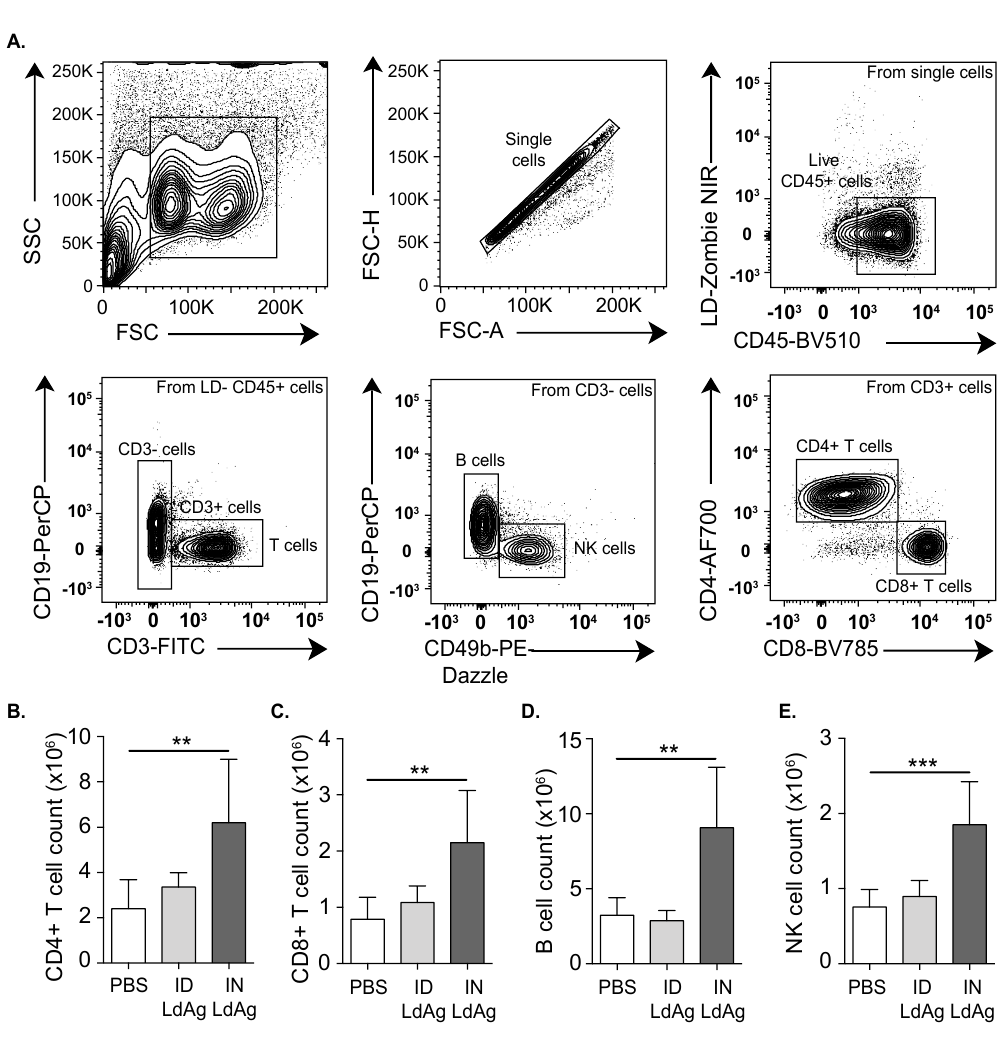
Fig 3. Intranasal administration of LdAg promotes lymphoid immune cells accumulation. (A) Representative flow cytometry plots providing the gating strategy for the identification of the principal immune populations in the spleen. (B-E) Impact of ID and IN LdAg immunization on the number of CD4+ T cells (B), CD8+ T cells (C), B cells (D) and NK cells (E), assessed by flow cytometry using count beads. Data are representative of two independent experiments and are presented as means ± SEM ( n = 5–7; one-way